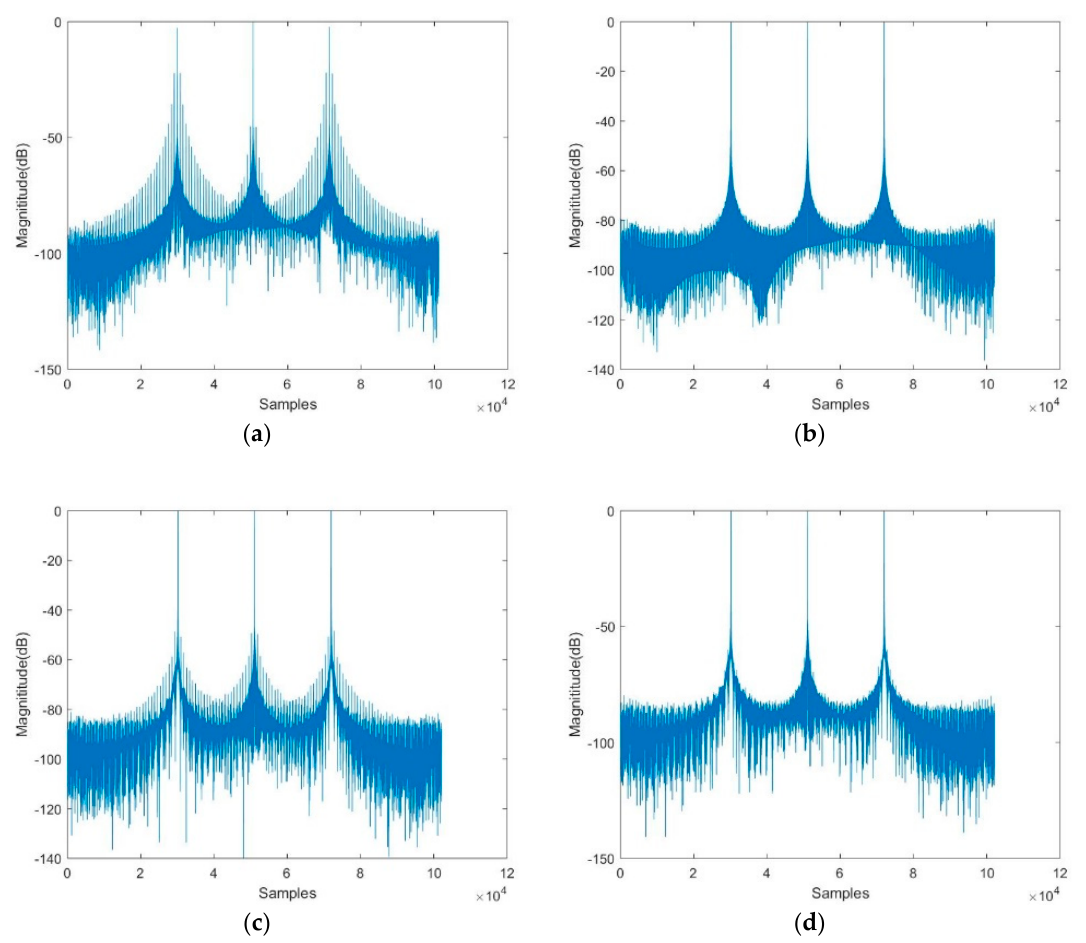
Figure 4. Nonuniform sampled signal with slow PRI change after compression. ( a ) Compression result with FFT. ( b ) Compression result with NUDFT. ( c ) Compression result with sinc interpolation. ( d ) Compression result with modified sinc interpolation.